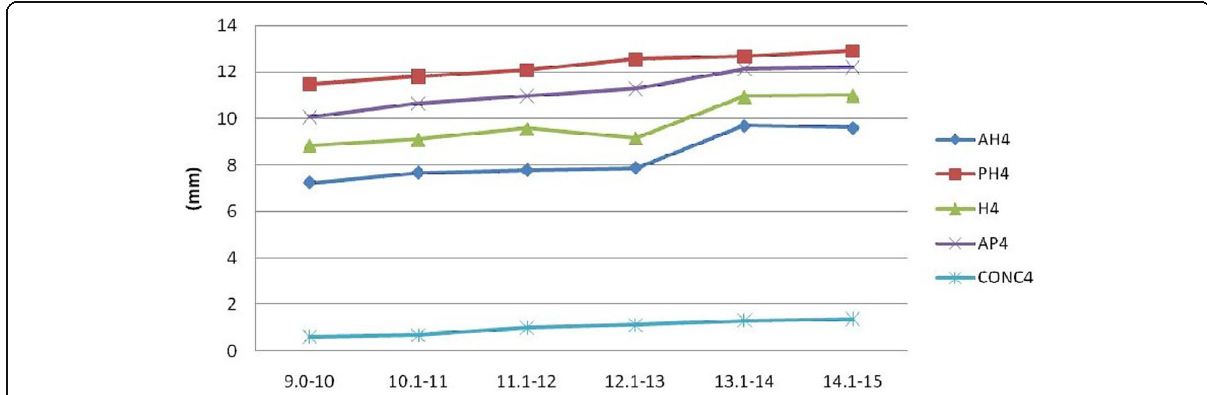
Fig. 5 Changes in the parameters of C4 in males (AH, anterior height; PH, posterior height; H, middle height; AP, anteroposterior length; CONC, depth of